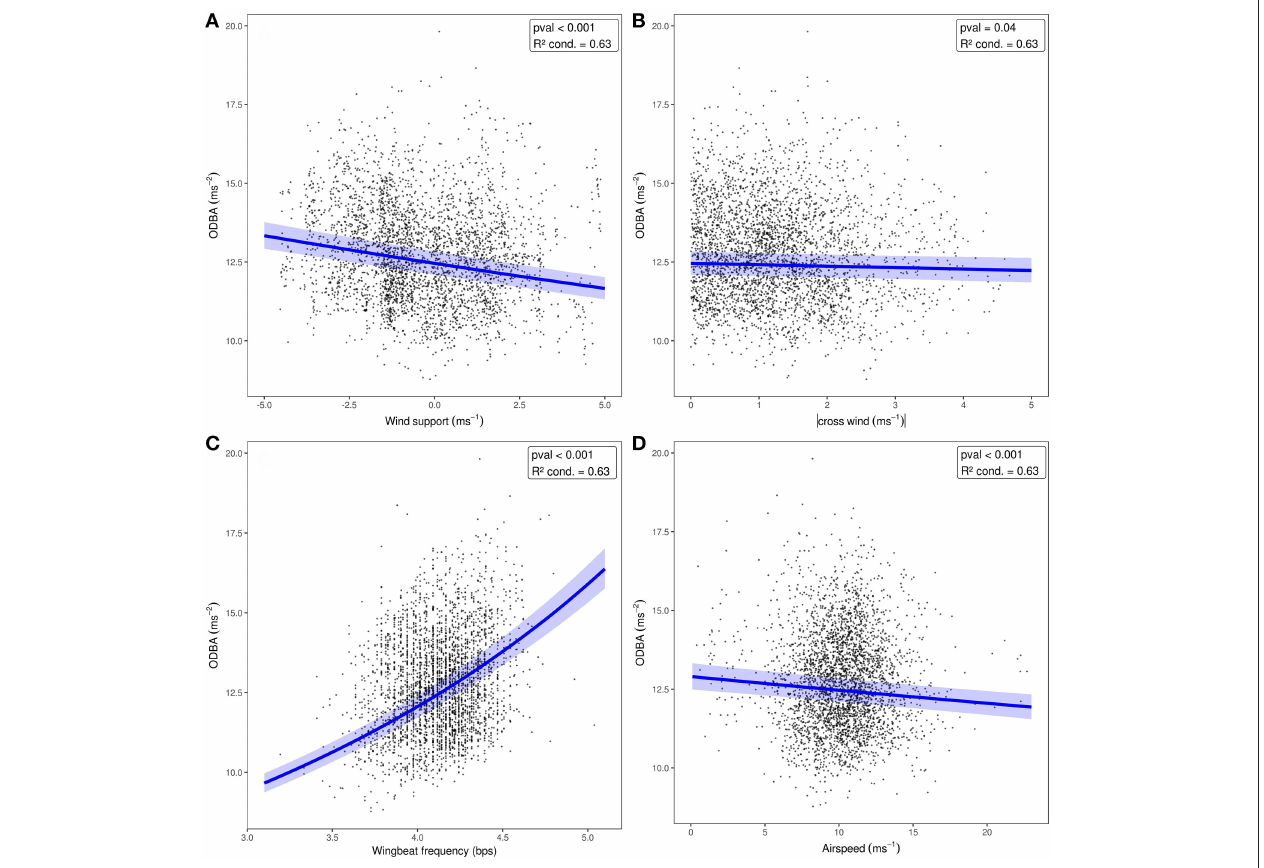
FIGURE 3 | ODBA relative to wind support (A) , crosswind (B) , wingbeat frequency (C) , and airspeed (D) included together in one model. The blue lines show predicted ODBA for each fixed effect where wingbeat frequency and airspeed were set to their means [4.2, 10.2, respectively for A,B ], and the effect of wind support and crosswind were set to 0 (C,D) . The 95% confidence interval for each model, including random effects, is shown as the shaded area around the line.